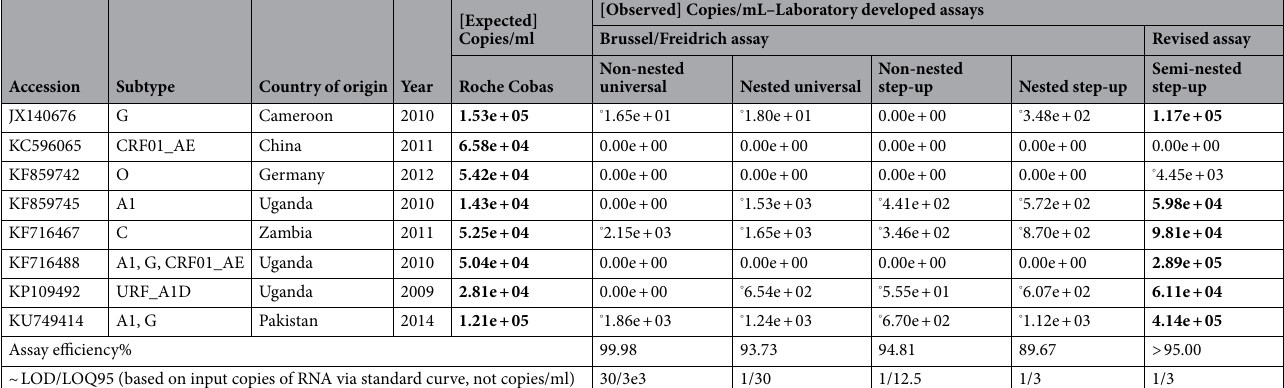
curve of > 90% efficiency, a linear range over 5 logs and a LLOD/LLOQ95 of 3 input copies of HIV RNA, but did not enhance the detection of non-detectable viral strains (Table 1). Subsequent sequence analysis of these oligonucleotide sets against the HIV-1 LANL compendium data- base, showed significant mismatch issues (Supplementary Table S2) and indicated the need to revise the assay oligonucleotides.